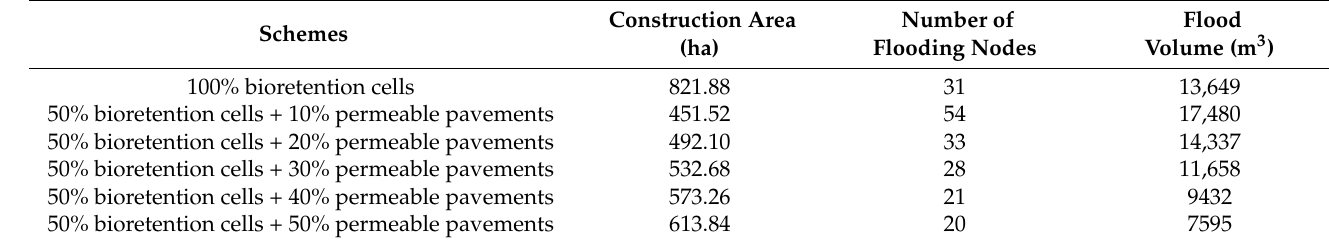
Figure 13. Outlet flow with different combination schemes ( p = 10 rainfall). Table 7. Waterlog of different combination schemes (P = 10